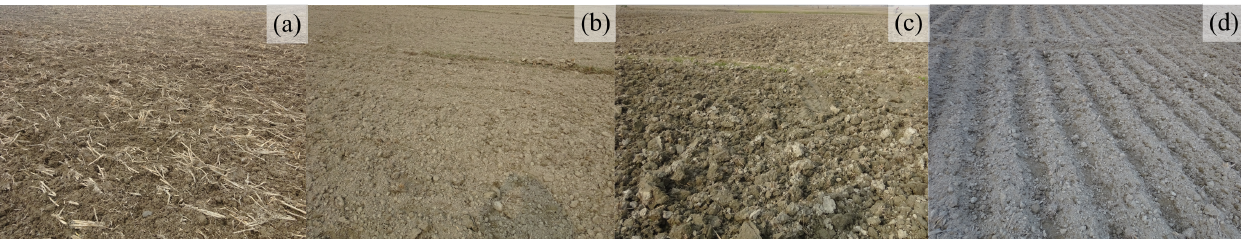
Figure 3. Surface undulation profile extracted after processing the photographs captured for the pin-profile using a digital camera in the field.